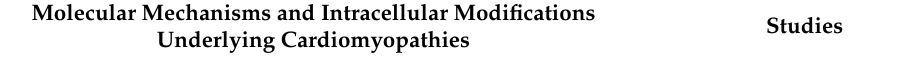
Table 4. Molecular mechanisms and intracellular modifications underlying